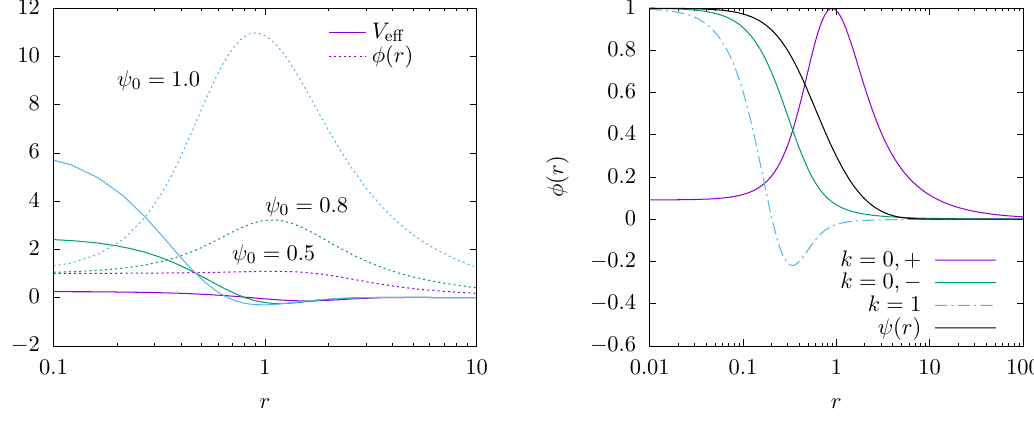
Figure 1 . We show the effective potential V eff (solid) of (3.9) for three different values of ψ 0 (see table 1 for the corresponding values of α , σ (0) and ω ) and α > 0, γ = 0 (left). We also show the profile of the scalar field function φ ( r ) in a boson star background with ψ 0 = 1 . 0, which corresponds to ω = 0 . 812. Two solutions without nodes (i.e. k = 0) of (3.4) exist in this case: one for α = 5 . 160 (purple solid) and one for α = 1 . 840 (green solid). We also show the profile for φ ( r ) for the first − excited solution, k = 1, which corresponds to α = 8 . 788 (blue dotted-dashed). For clarification, − we also plot the profile of the boson star scalar field ψ ( r ) (solid black). Note that φ ( r ) has been divided by its maximal value for the k = 0, α = 5 . 160 case.